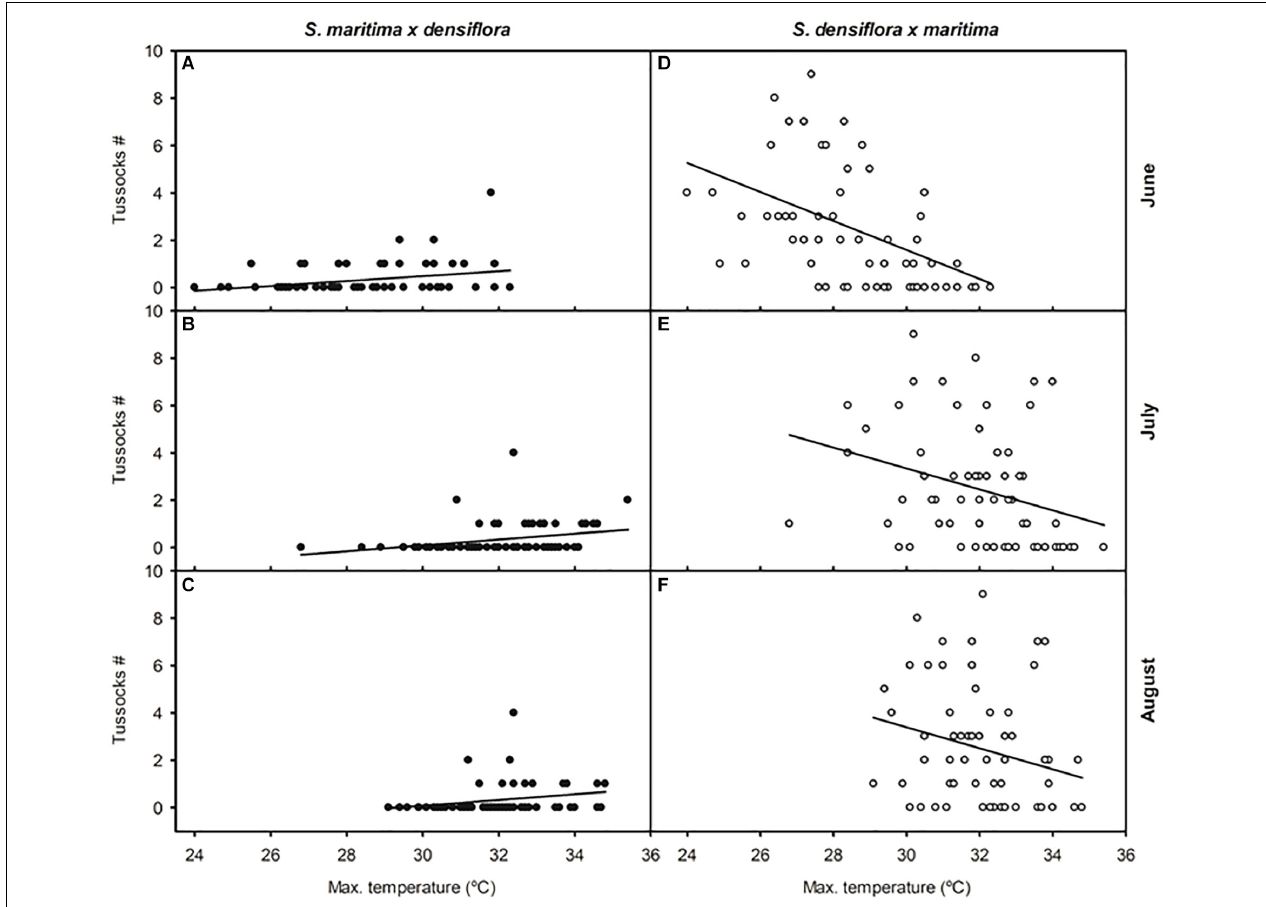
FIGURE 3 | Relationships between the number of annually established tussocks of Spartina hybrids and mean maximum temperatures from 1955 to 2017 on the Gulf of Cadiz (Southwest Iberian Peninsula). Taxa: Spartina maritima × densiflora (black symbols); S. densiflora × maritima (white symbols). Months: (A,D) June, (B,E) July, and (C,F) August. Regression equations ( N = 61–62): (A) y = –2.612 + 0.103x, R = 0.28, P < 0.05; (B) y = –3.605 + 0.123x, R = 0.30, P < 0.05; (C) y = –3.537 + 0.121x, R = 0.25, P = 0.05; (D) y = 19.957 – 0.612x, R = 0.47, P < 0.0001; (E) y = 16.617 + 0.442x, R = 0.30, P < 0.05; (F) y = 16.717 + 0.444x, R = 0.25, P <